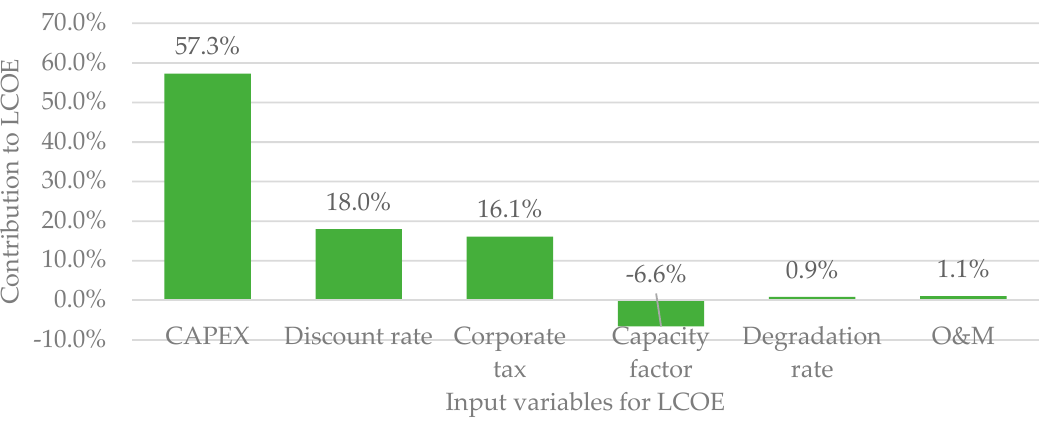
Figure 12. Sensitivity of the commercial solar LCOE.